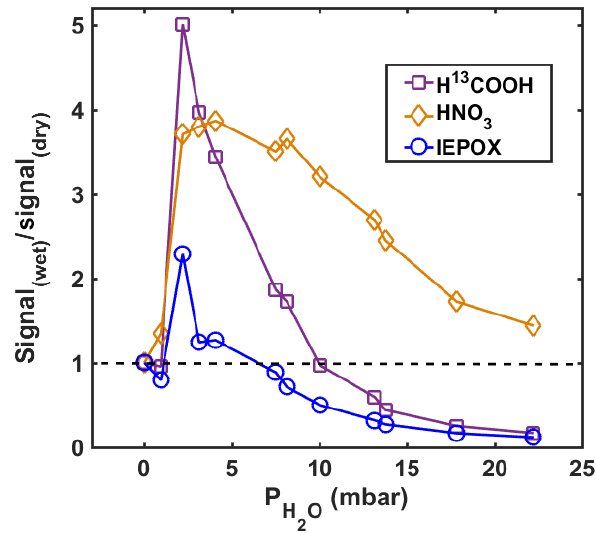
Figure 6. Normalized signal of I(HNO 3 ) − , I(H 13 COOH) − , and ) in the I(IEPOX) − as a function of water vapor pressure ( P H 2 O IMR. The signal of iodide–analyte clusters is first normalized by the total reagent ion (I − and I(H 2 O) − ) signals. The resulting nor- malized signal at each P H was then normalized again to the re- 2 O = 0, dry UHP N spective value under dry conditions ( P H 2 ) 2 O